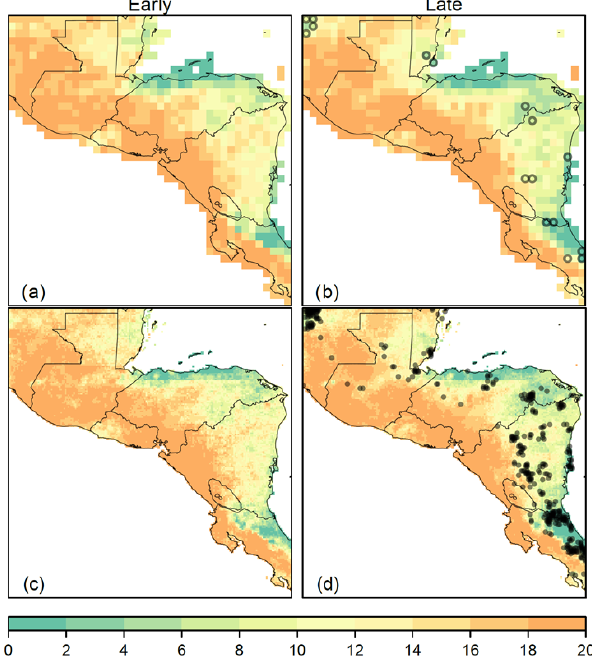
Figure A1. Number of years out of 20 with an MSD in the early and late periods using 0.25 ◦ aggregated data (a, b) and an original CHIRPS resolution of 0.05 ◦ (c, d) . Circles in panel (b) indicate the difference in proportions of MSD years in the two periods is statistically significant based on Fisher’s exact test.